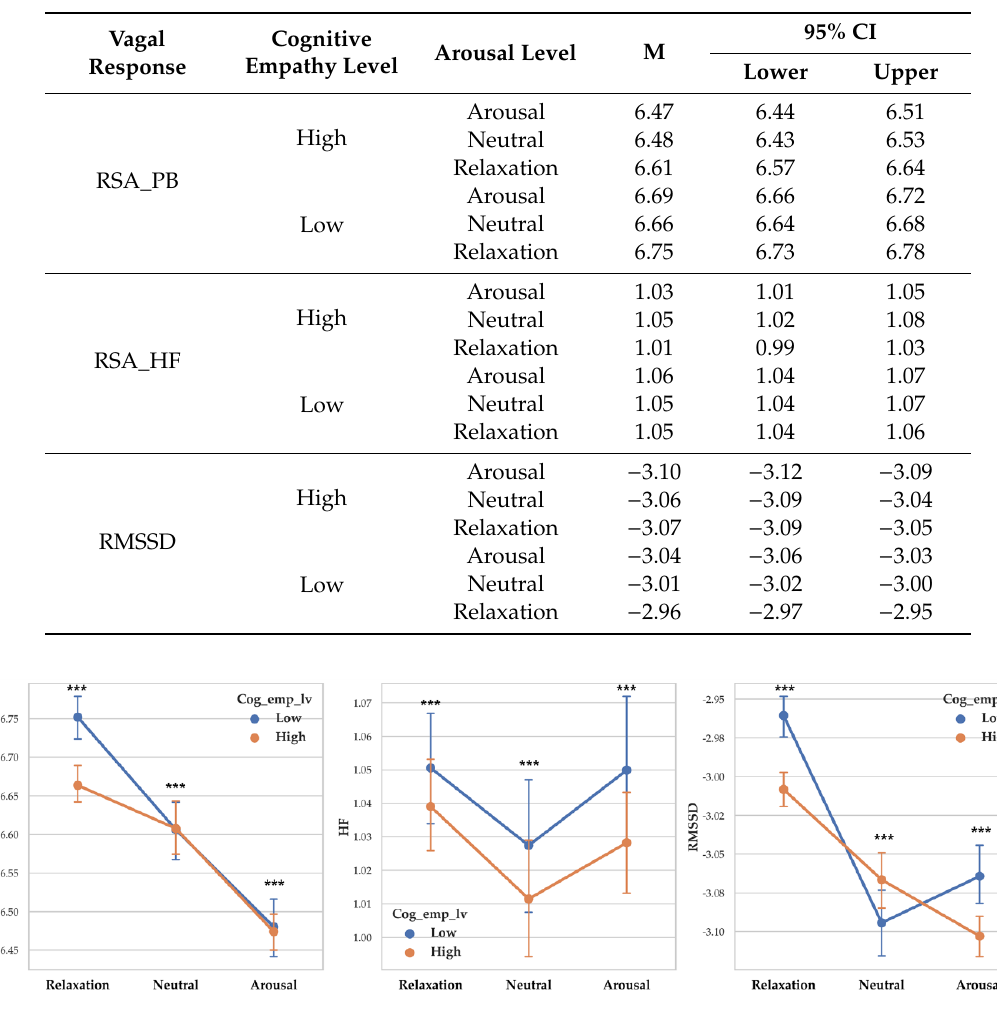
Figure 5. Point graph of vagal response depending on cognitive empathy level and arousal. Cog_emp_lv refers to cognitive empathy level. Point means mean of vagal responses and error bars represent confidence interval. Asterisk means significant vagal responses difference according to cognitive empathy level. (***: p < 0.001.).